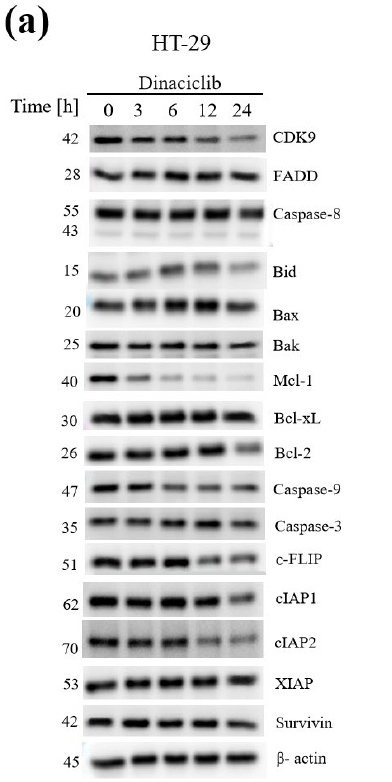
Figure 5. CDK9 inhibition may overcome TRAIL resistance by suppression of c-FLIP and Mcl-1. ( a ) HT-29 cells were treated with 25 nM Dinaciclib for the indicated periods. Cells were lysed and subjected to western blotting to dermine the levels of CDK9, FADD, Caspase-8, Bid, Bax, Bak, Mcl-1, Bcl-xL, Bcl-2, Caspase-9, Caspase-3, c-FLIP, cIAP1, cIAP2, XIAP, and Survivin at the indicated timepoints. β -actin was used as a loading control. ( b ) SW-620 and DLD-1 cells were lysed and ana- lyzed by western blotting concering the expression levels of CDK9, Mcl-1, c- FLIP. β -actin was used as a loading control. One representative of two independent experiments is shown.